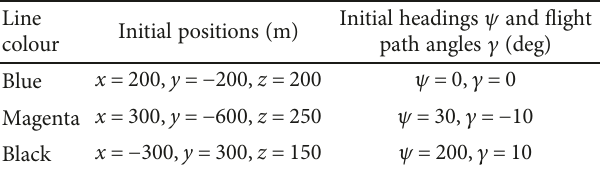
Figure 13: Cross-track errors in general path following. Table 2: Initial conditions used in